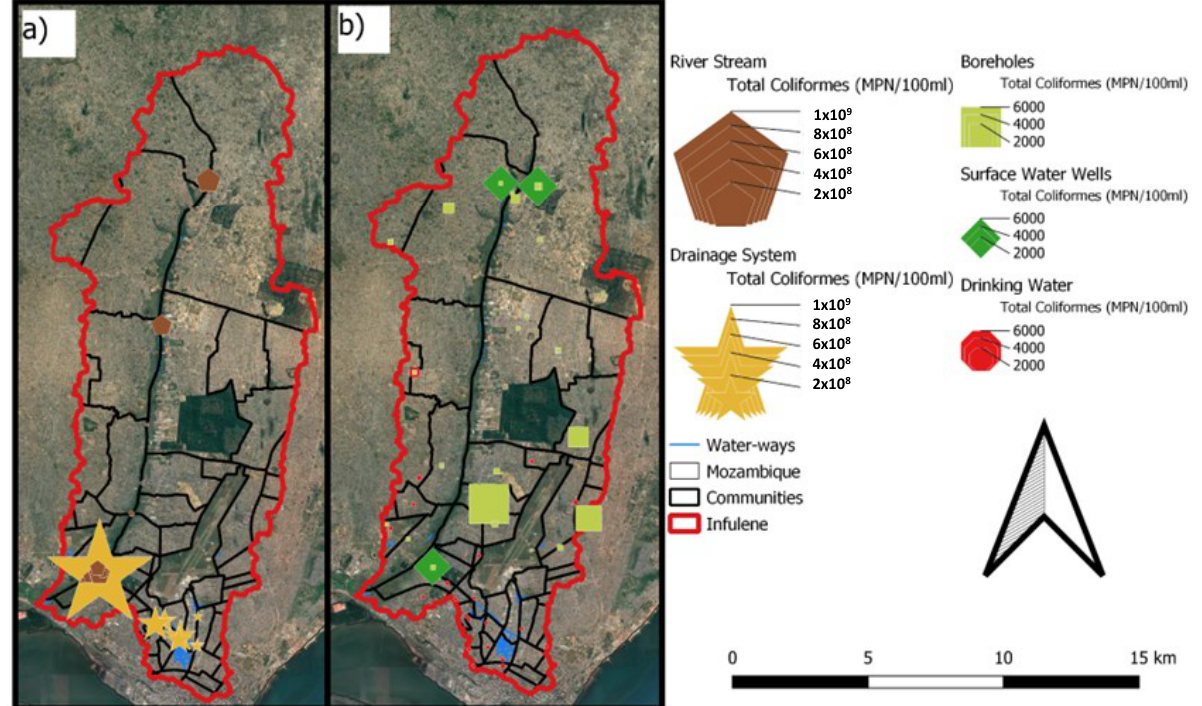
Figure 8. Spatial analysis of concentration of TC, considering separately ( a ) the river water with drainage water and ( b ) the drinking water.